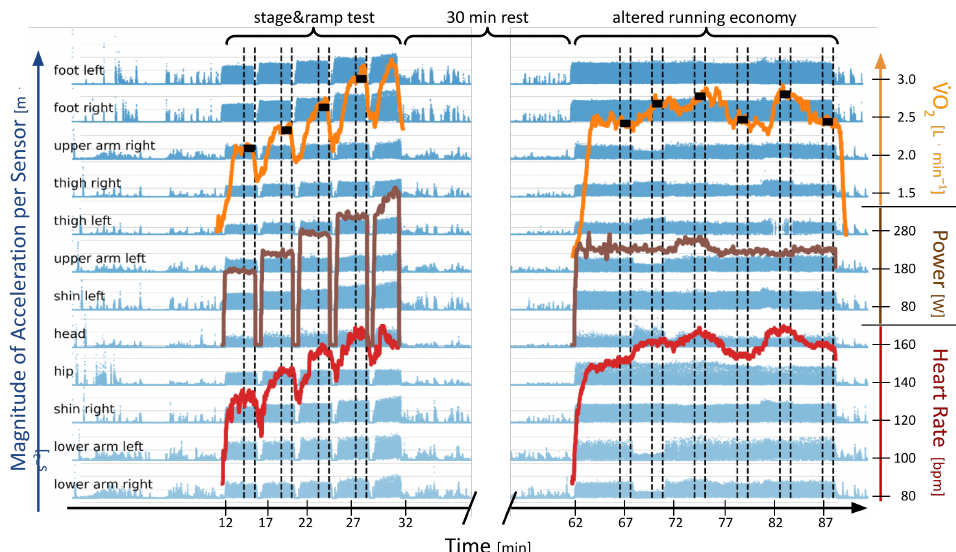
Figure 1. Overview of all collected data for a single athlete: the magnitude of accelerometers at 12 positions on the body (blue); red: heart rate; brown: running power (Stryd); orange: ˙VO 2 ; dashed lines = time section used for tests; in the left half is the last 60 s of each stage in the graded exercise test; on the right are the last 60 s of each modified running condition; black boxes mark the ˙VO 2 average for each section. Best viewed in color.